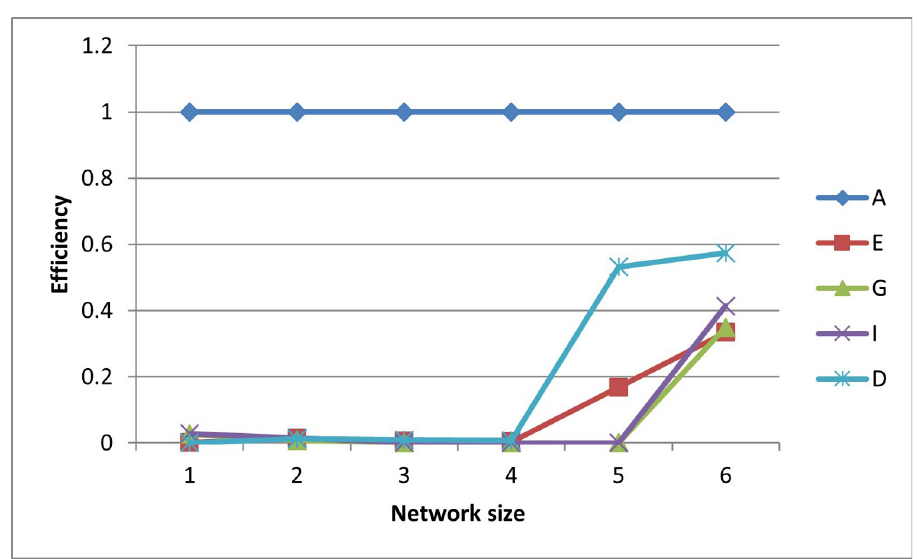
Fig 6. A- efficiencies of various optimal designs for the first case study.